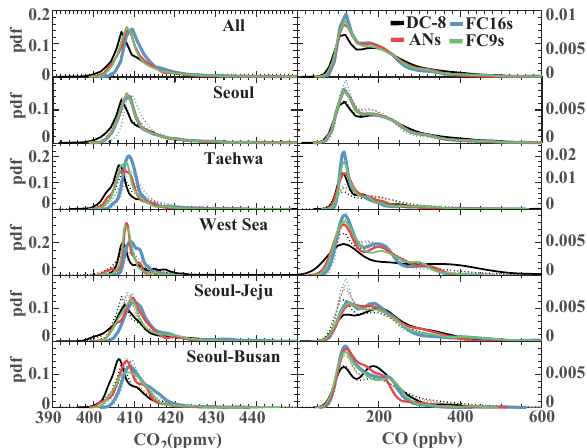
Figure 3. Probability density functions (pdfs) of CO 2 and CO for each flight group. Solid lines are pdfs for each group while the dashed lines are pdfs for all